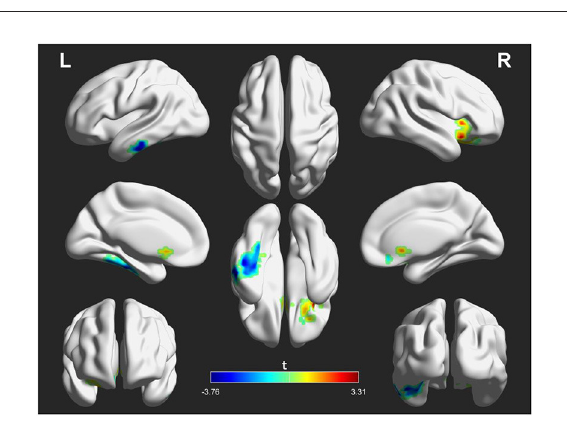
FIGURE3 Differences in functional connectivity (FC) of the nucleus accumbens seeds between patients after treatment and before treatment. The warm color indicates an increased FC of seed with the whole brain and the cool color indicates a decreased FC of seed with the whole brain. The color scale is represented by the t -value of statistically significant clusters with the voxel-level statistical threshold of p < 0.05 and a cluster-level threshold of p < 0.05 corrected for the Gaussian random field (size > 30).